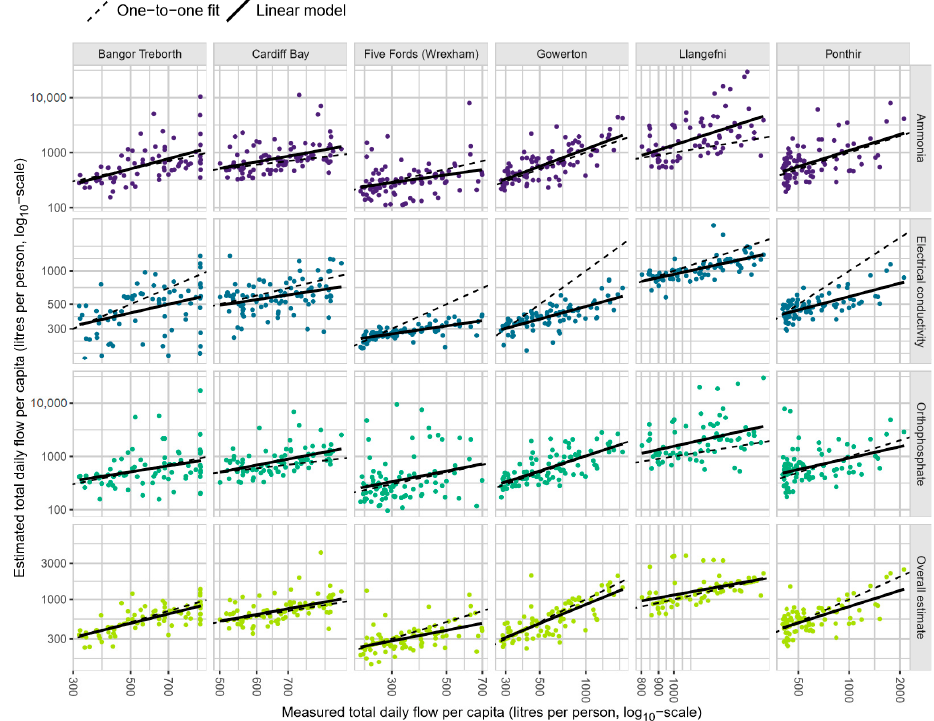
Figure 2. Scatter plots of estimated volume and measured total daily flow at six wastewater treatment sites in Wales over a 21-week period up to 7 March 2022. The overall estimate (bottom row) was calculated according to Equations (5) and (6). Each plot includes a dashed line corresponding to a one-to-one fit, and a solid line showing a simple linear regression between the two axes. Both axes are given on a log10-scale.